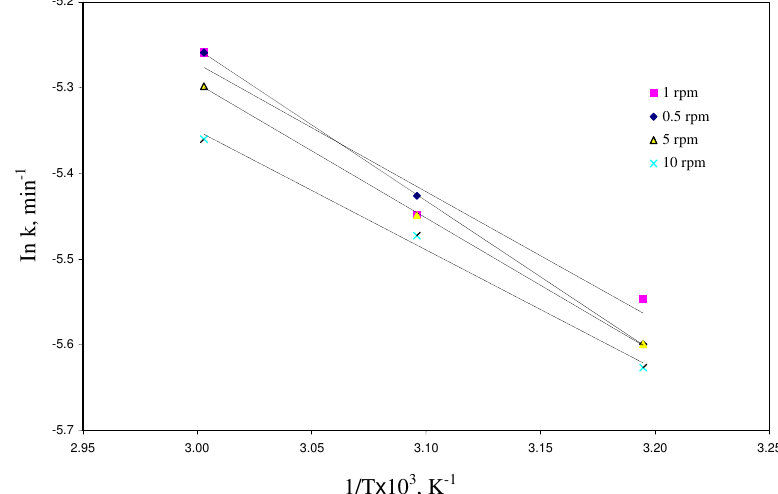
Figure 5 . Plots of ln k vs .1/T of the propellant slurry at different shear